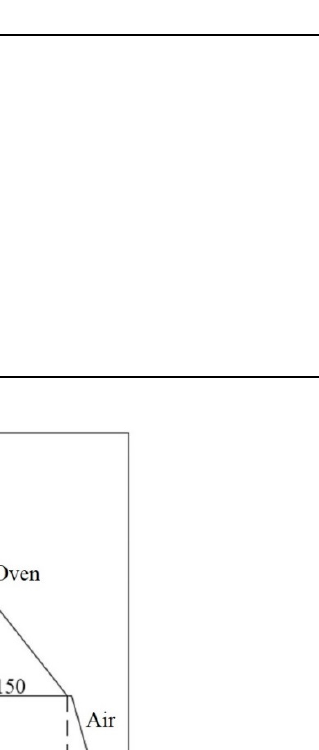
Table 1. Chemical composition of Nimonic 80A, weight %.